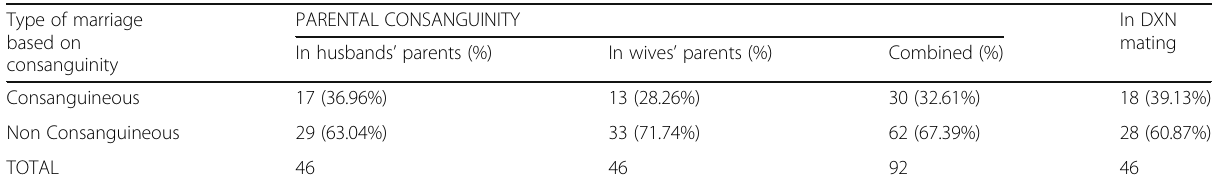
Table 3 Consanguinity in parents of DXN mating and in DXN